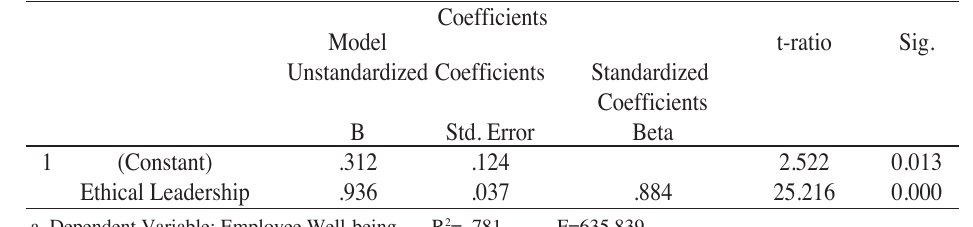
Table 5. Regression Analysis between Ethical Leadership and Employee Well-Being